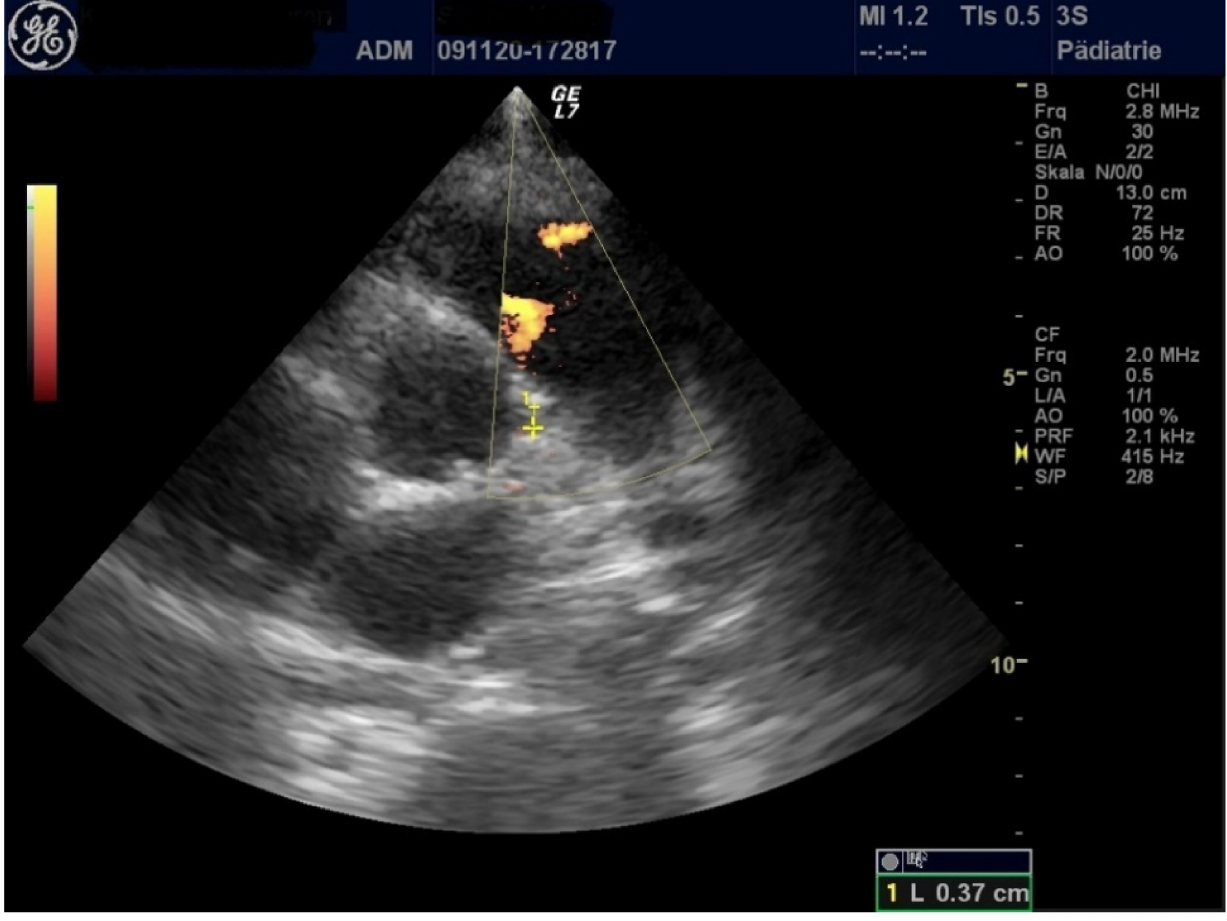
Figure 1. Left coronary artery with normal diameter.